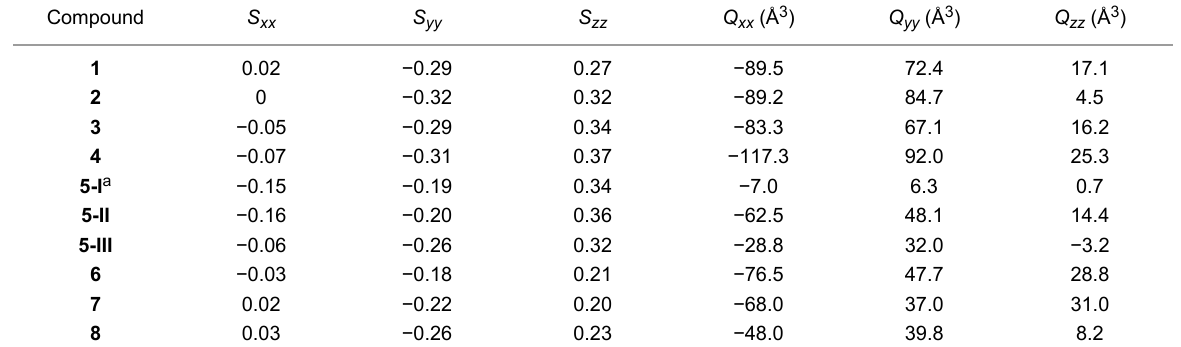
Table 2: Principal elements of the Saupe ordering matrix, S , and corresponding elements of the chirality tensor Q . Axis labels are shown in Figure 3. Compound